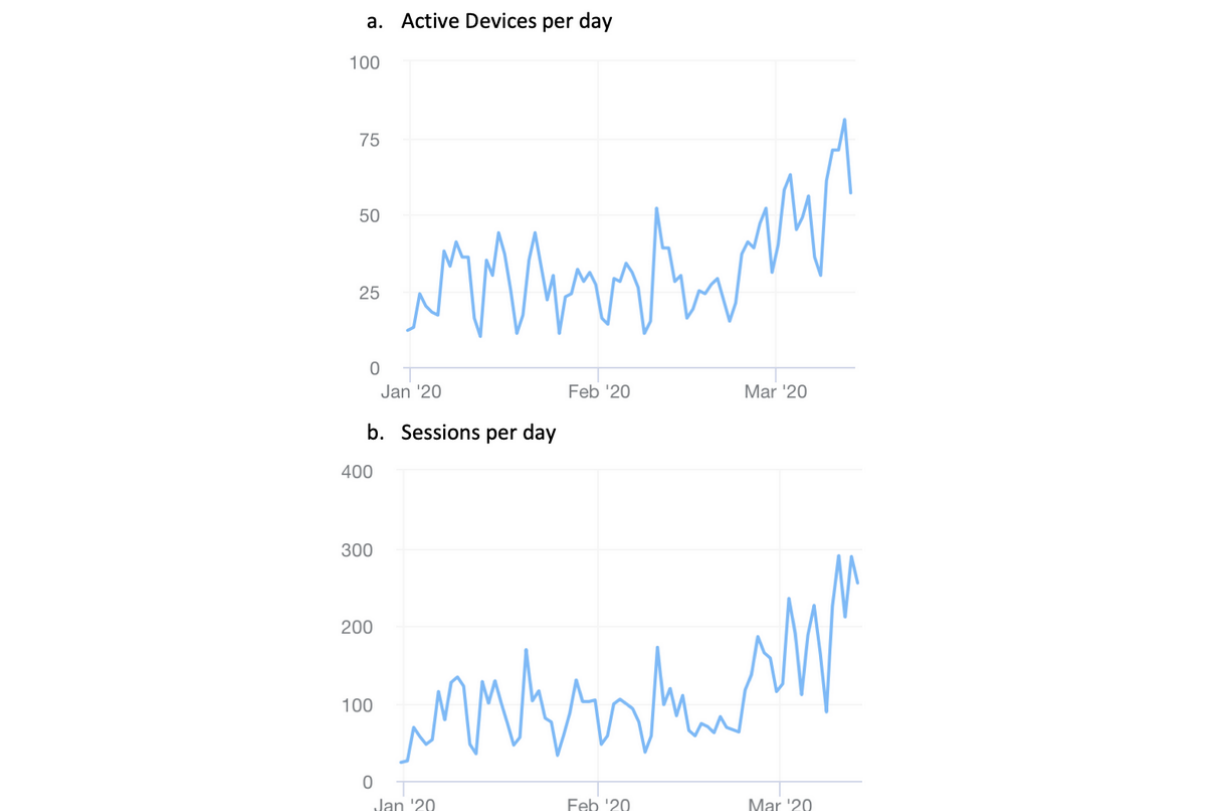
Figure 2. Mobile platform user activity between January 01, 2020, and March 13, 2020.